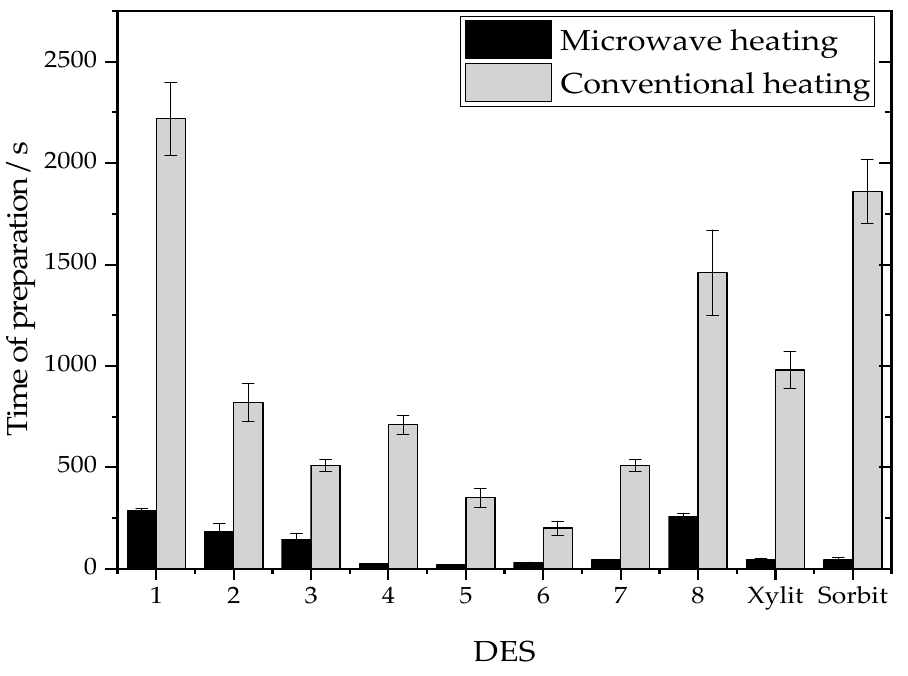
Figure 2. Preparation times of common and sugar-alcohol DESs with microwave heating and thermal heating, mean standard deviation indicates significant differences ( p < 0.05).